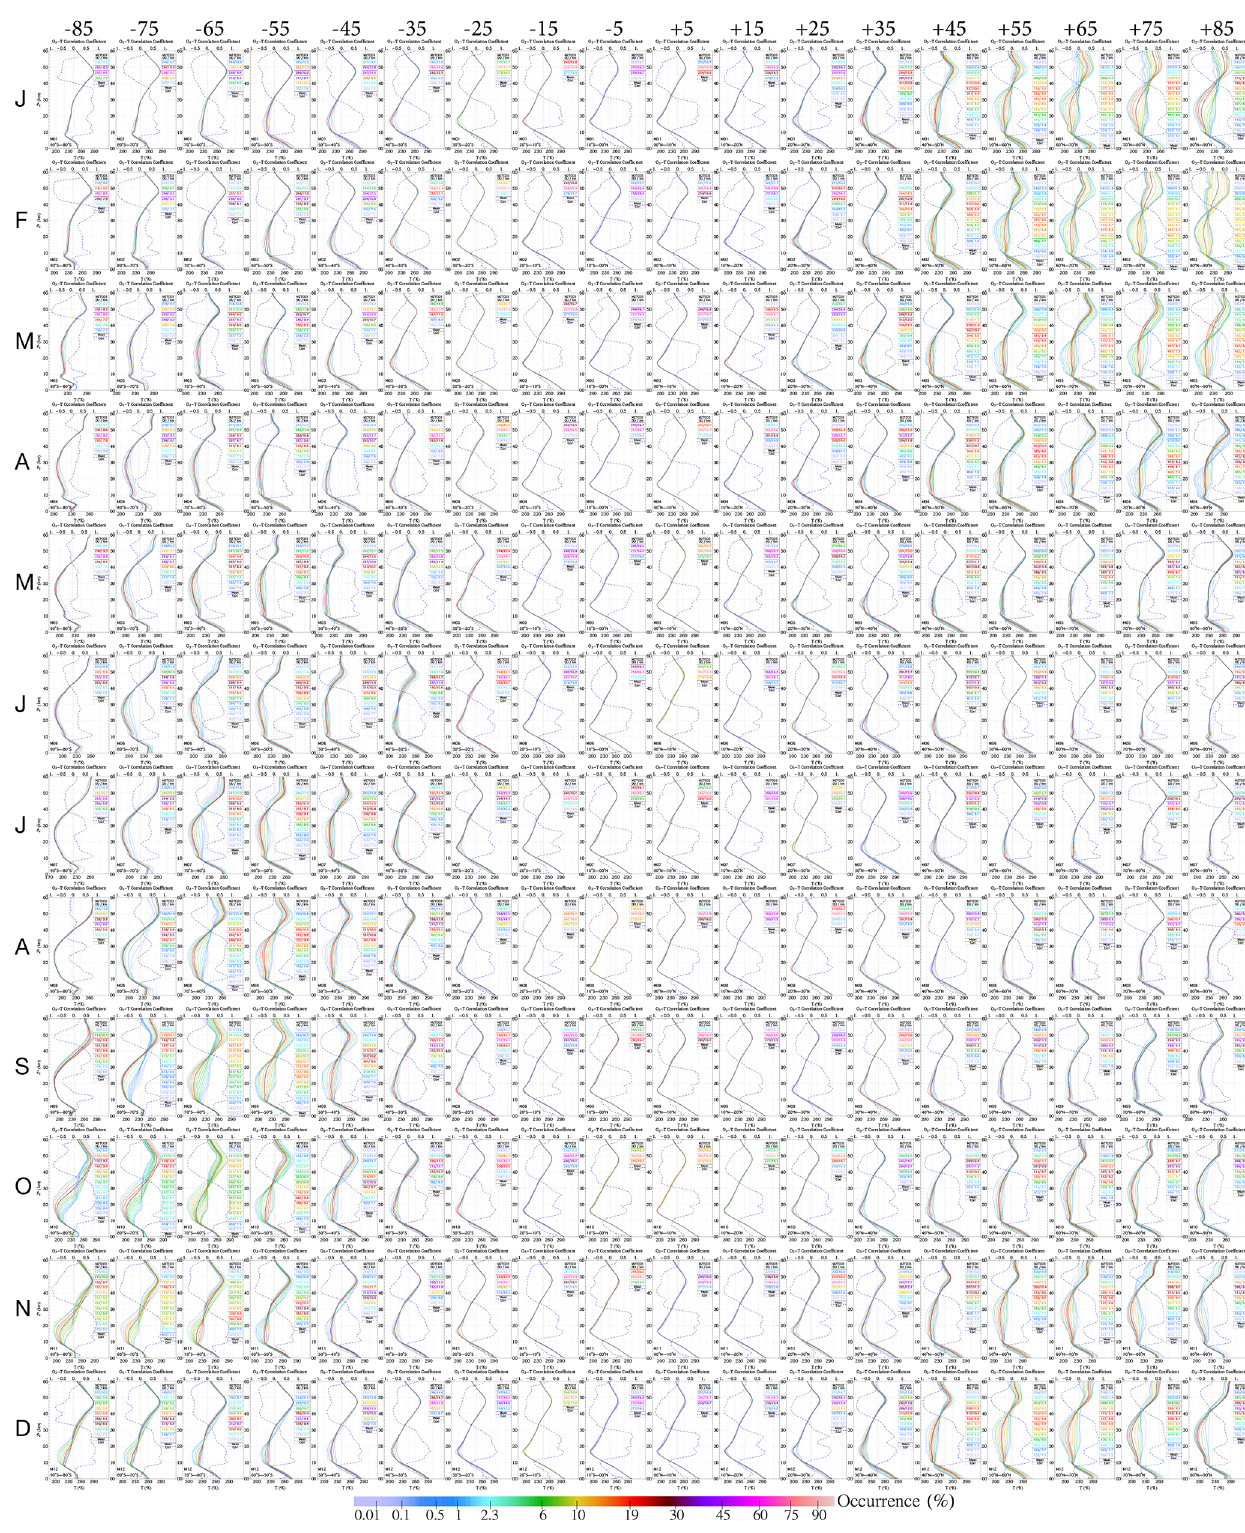
Figure A6. Climatological temperature profiles corresponding to the daytime M2TCO3 O 3 profiles shown in Fig. A3. The color scheme is the same as that in Fig. A3. The dashed dark blue line represents the coefficient of correlation between O 3 partial pressure and temperature as a function of pressure altitude Z ∗